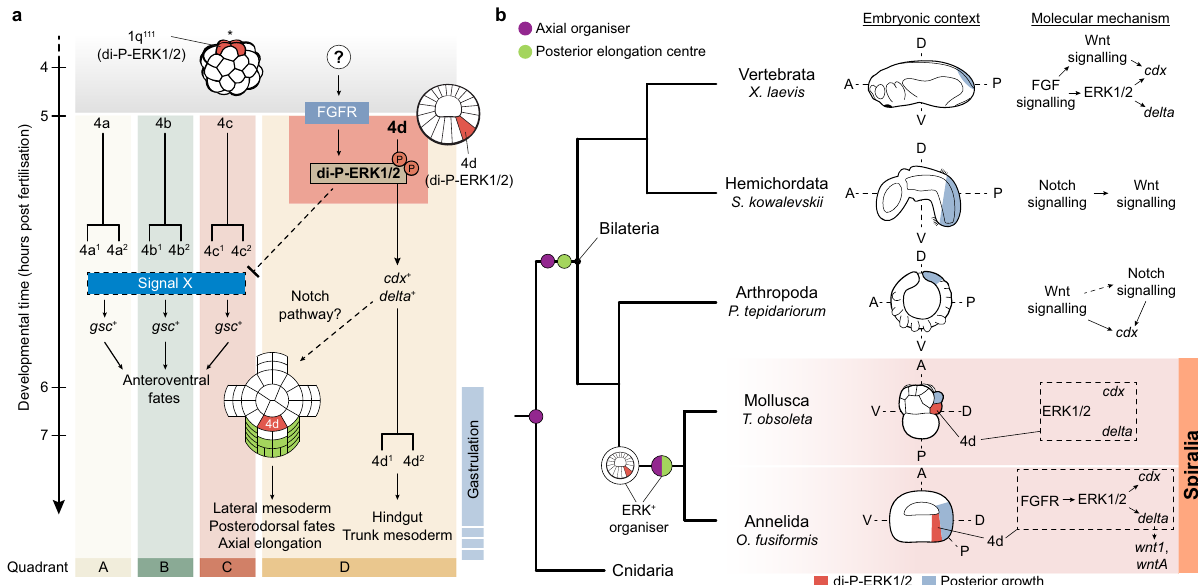
Fig. 9 ERK1/2 activity in the D-quadrant embryonic organiser is an ancestral spiralian trait. a Schematic model of FGFR/ERK1/2 activity in the 4d micromere during late spiral cleavage in O. fusiformis . At 4 h post fertilisation (hpf), di-phosphorylated ERK1/2 (di-P-ERK1/2) is enriched in the apical most micromeres (1q 111 ). At 5 hpf, an unidenti fi ed signal activates FGF receptor which di-phosphorylates ERK1/2 in the 4d micromere. This activates cdx and delta in 4d (becoming the endomesodermal precursor), which also correlates with 4d arresting its cell cycle progression, as 4a – 4c cleave. ERK1/2 activation in 4d is required to limit anterior genes (e.g., gsc ) to the A – C quadrants, yet the exact nature of this interaction is unclear (dotted lines). In addition, ERK1/2 activity in 4d induces the expression of a battery of genes in the D-quadrant and part of the C-quadrant that probably induces lateral mesodermal and posterodorsal fates, ultimately controlling axial elongation. Beginning at this stage, the Notch-Delta pathway is required for normal posterodorsal development and might contribute to transmit the inductive activity of 4d cell to neighbouring cells (dotted line). b Schematic drawings of embryos at the time of anteroposterior axial elongation in different bilaterian lineages, with the interactions between FGFR, ERK1/2 and some of the candidate genes identi fi ed in this study in each lineage depicted to the left. The similar involvement of ERK1/2 activation in the speci fi cation of the D-quadrant embryonic organiser in O. fusiformis and other molluscan embryos suggests that the presence of an ERK1/2 positive embryonic organiser is a shared ancestral trait to spiral cleavage. More broadly, ERK1/2 activity induces the expression of a set of genes and signalling pathways that are repeatedly involved in axial patterning and posterior trunk growth in bilaterian embryos. While axial organisation and the formation of a posterior elongation centre are most often spatially and temporally uncoupled in most bilaterian lineages, they become integrated into a single developmental process of embryonic organising activity (i.e., the speci fi cation of the D-quadrant embryonic organiser) in spiralians. Drawings are not to scale. A anterior, P posterior, D dorsal, V